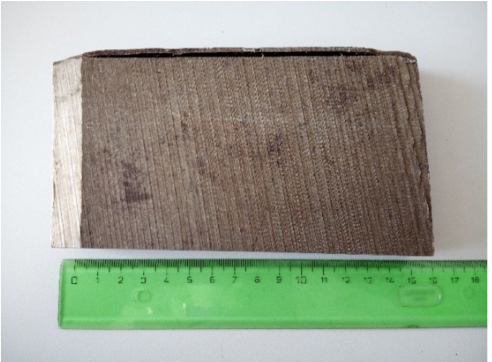
Figure 1. Illustrative cross-section from VVER-440 RPV (Original not-irradiated peace from VVER-440 V-213 RPV—Greifswald Unit